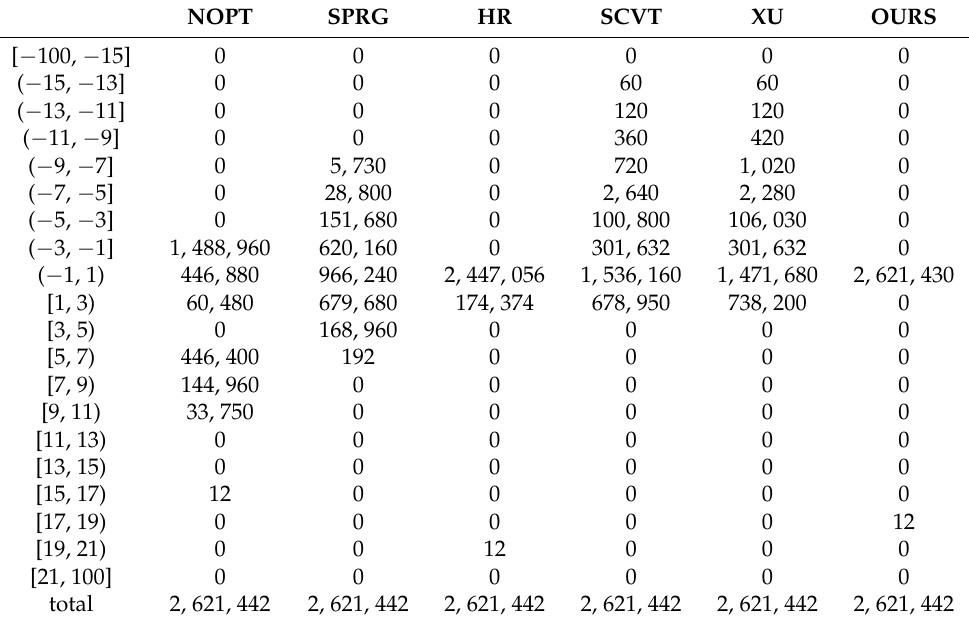
Figure 10. Ratios between minimum and maximum distance of different grids. Table 8. The number of grids with different D length interval of different grids.